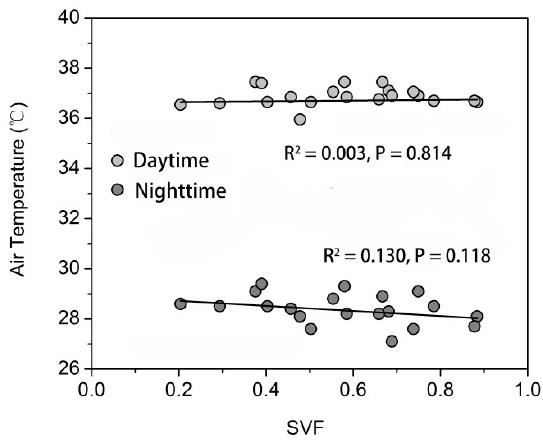
Figure 8. Relationships between the air temperature and sky view factor at different times.